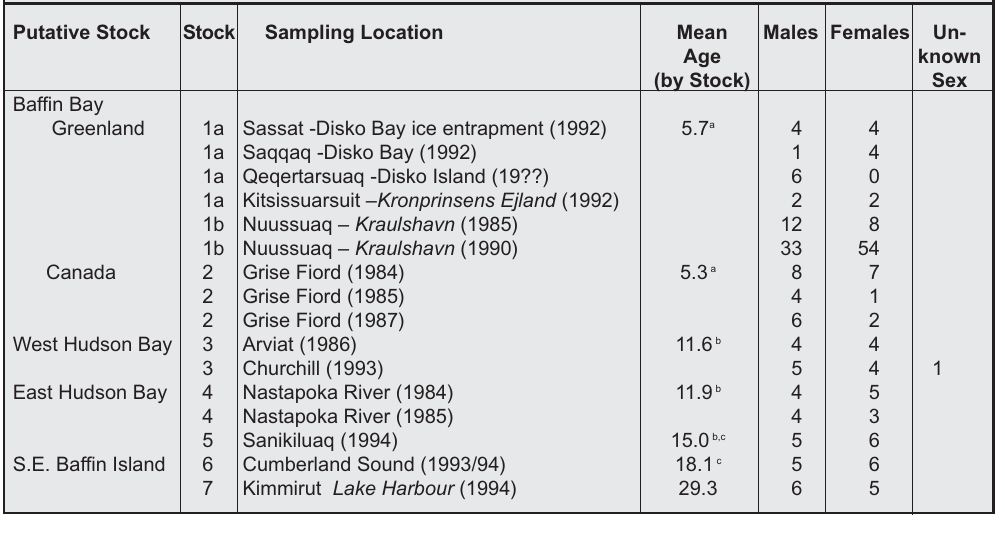
Table 1. Sampling locations and times, sex and mean age of sampled beluga from five putative stocks and three other locations. Mean ages with the same superscript letter were not signifi- cantly different from each other ( P =